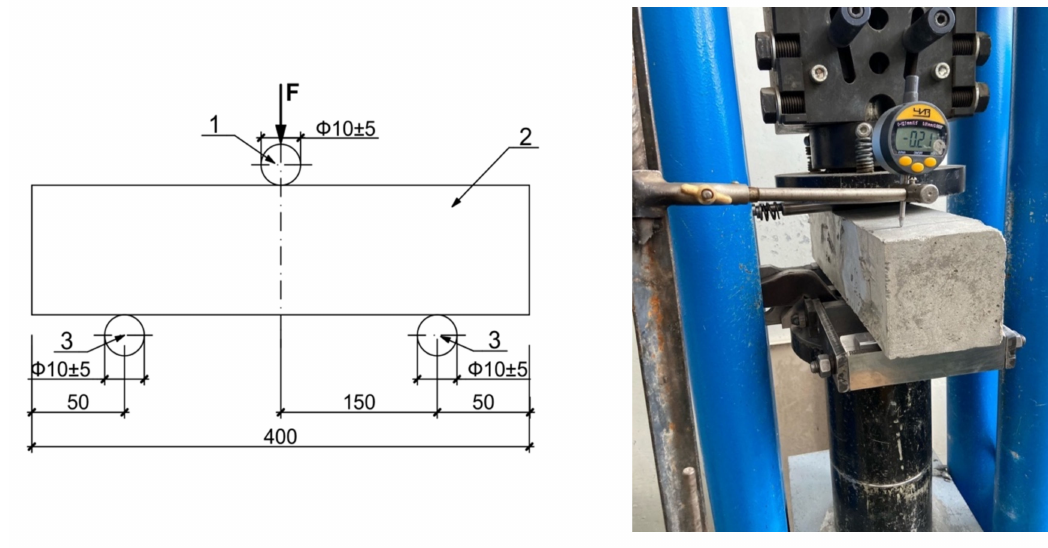
Figure 2. Bending tensile testing scheme 1—loading element; 2—beam sample;